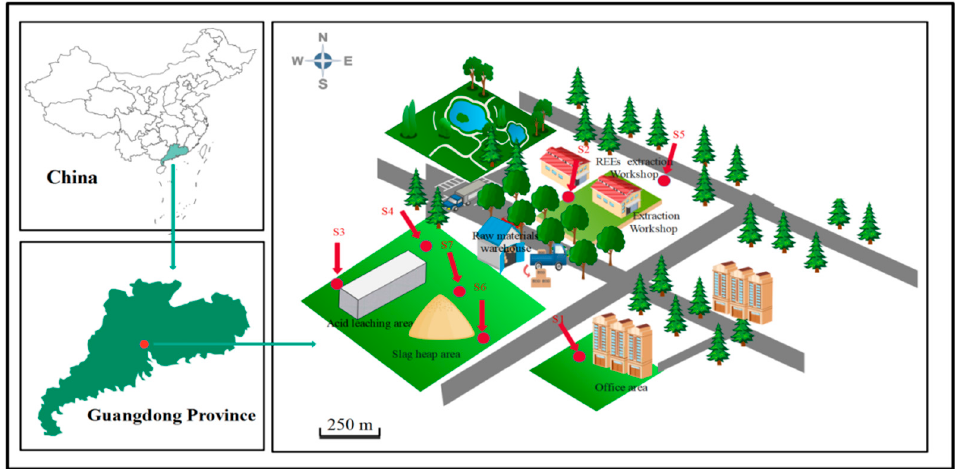
Figure 1. Schematic illustration of sampling sites in a decommissioned REE plant, Guangdong,